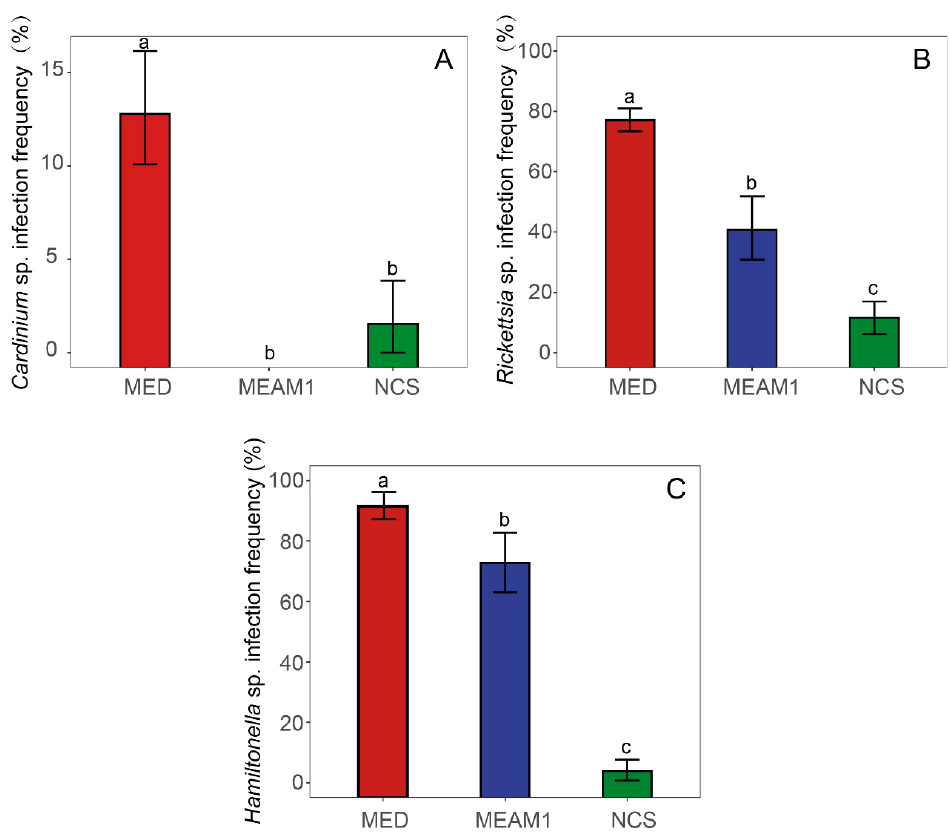
Figure 5. Infection frequency of Cardinium sp., Rickettsia sp., and Hamiltonella sp. in Bemisia tabaci populations. ( A ): the Cardinium infection frequency; ( B ): the Rickettsia infection frequency; ( C ): the Hamiltonella infection frequency. The red indicates endosymbionts’ infection frequency in the MED, blue indicates endosymbionts’ infection frequency in MEAM1, and green indicates endosymbionts’ infection frequency in NCS. Lowercase letters on the bar indicate the significant difference at the 0.05 level.